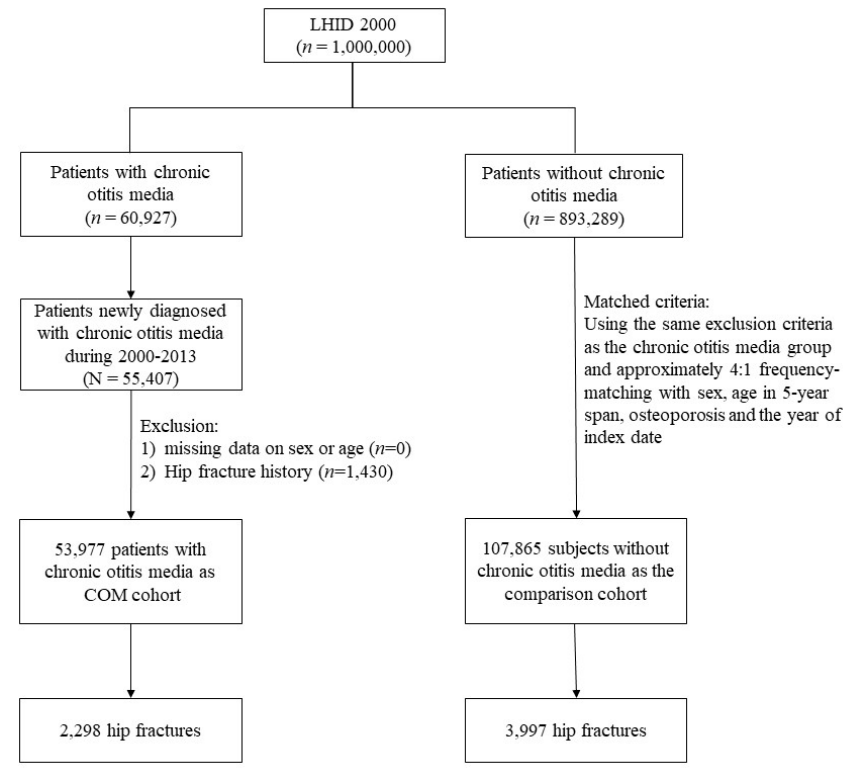
Figure 1. The flow diagram of the recruitment process. There were 2298 hip fractures in the COM cohort with an incidence density of 4.48 per 1000 person-years. As for the comparison cohort, 3997 individuals suffered from hip fractures with an incidence density of 3.92 per 1000 person-years (Table 2). The cumulative incidence of hip fracture was higher in the COM cohort than in the comparison cohort (Figure 2, p < 0.001 for log-rank test). After adjustment for gender, age, and all of the enlisted comorbidities, the subjects in the COM cohort had a 1.11-fold risk of hip fracture than the individuals in the comparison cohort (aHR = 1.11; 95% CI = 1.05–1.17). Age, gender, hypertension, diabetes, epilepsy, chronic obstructive pulmonary disease, stroke, and osteoporosis were also associated with a higher incidence of hip fracture in our model. Table 2. The incidence density of hip fracture stratified by the history of chronic otitis media, gender, age, and comorbidities. Variable